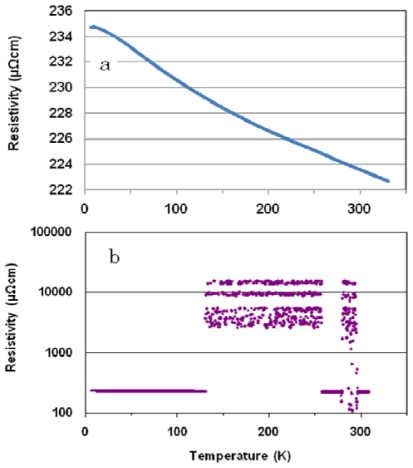
The temperature dependence of the resistivity of polished (Ni0.39Nb0.26Zr0.35)90.5H9.5 glassy alloy in cooling run (a) and heating run (b).